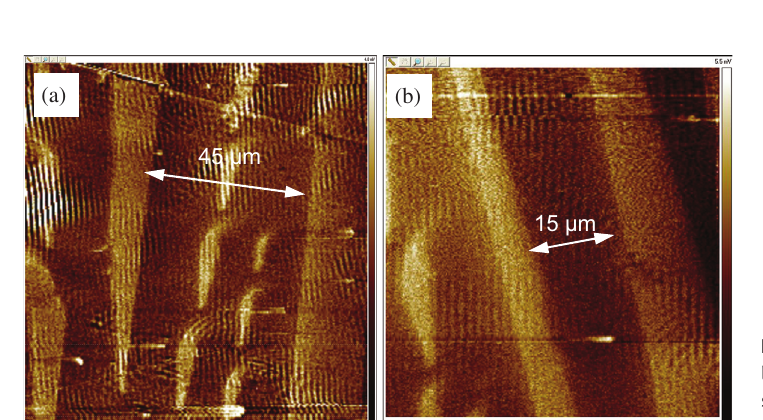
Figure 3: (a) Domains made visi- ble by Ferrofluid in the silicon steel with 5 mJ laser treatment, (b) domains in the 50 mJ laser- treated silicon steel.